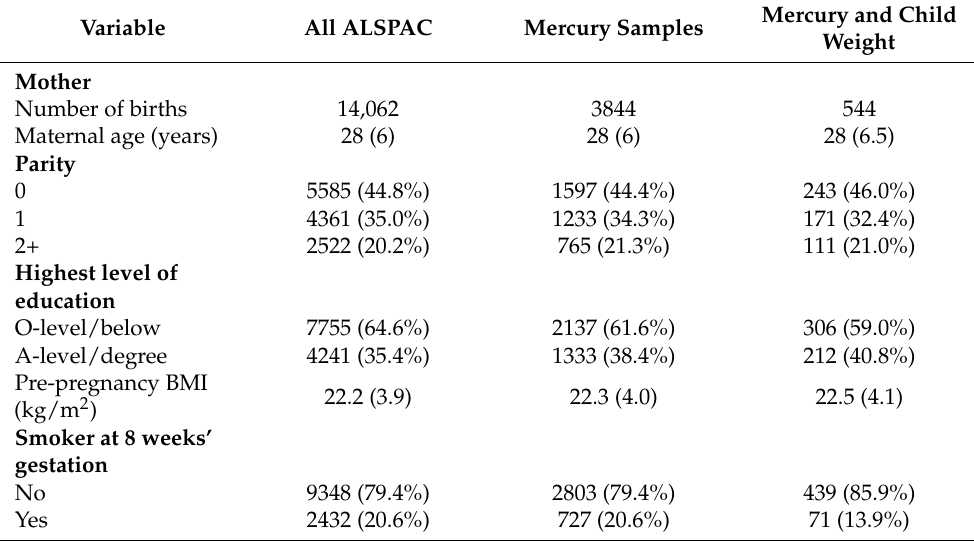
Table 1. Characteristics of mother and child in ALSPAC and study samples. Median (IQR) or count